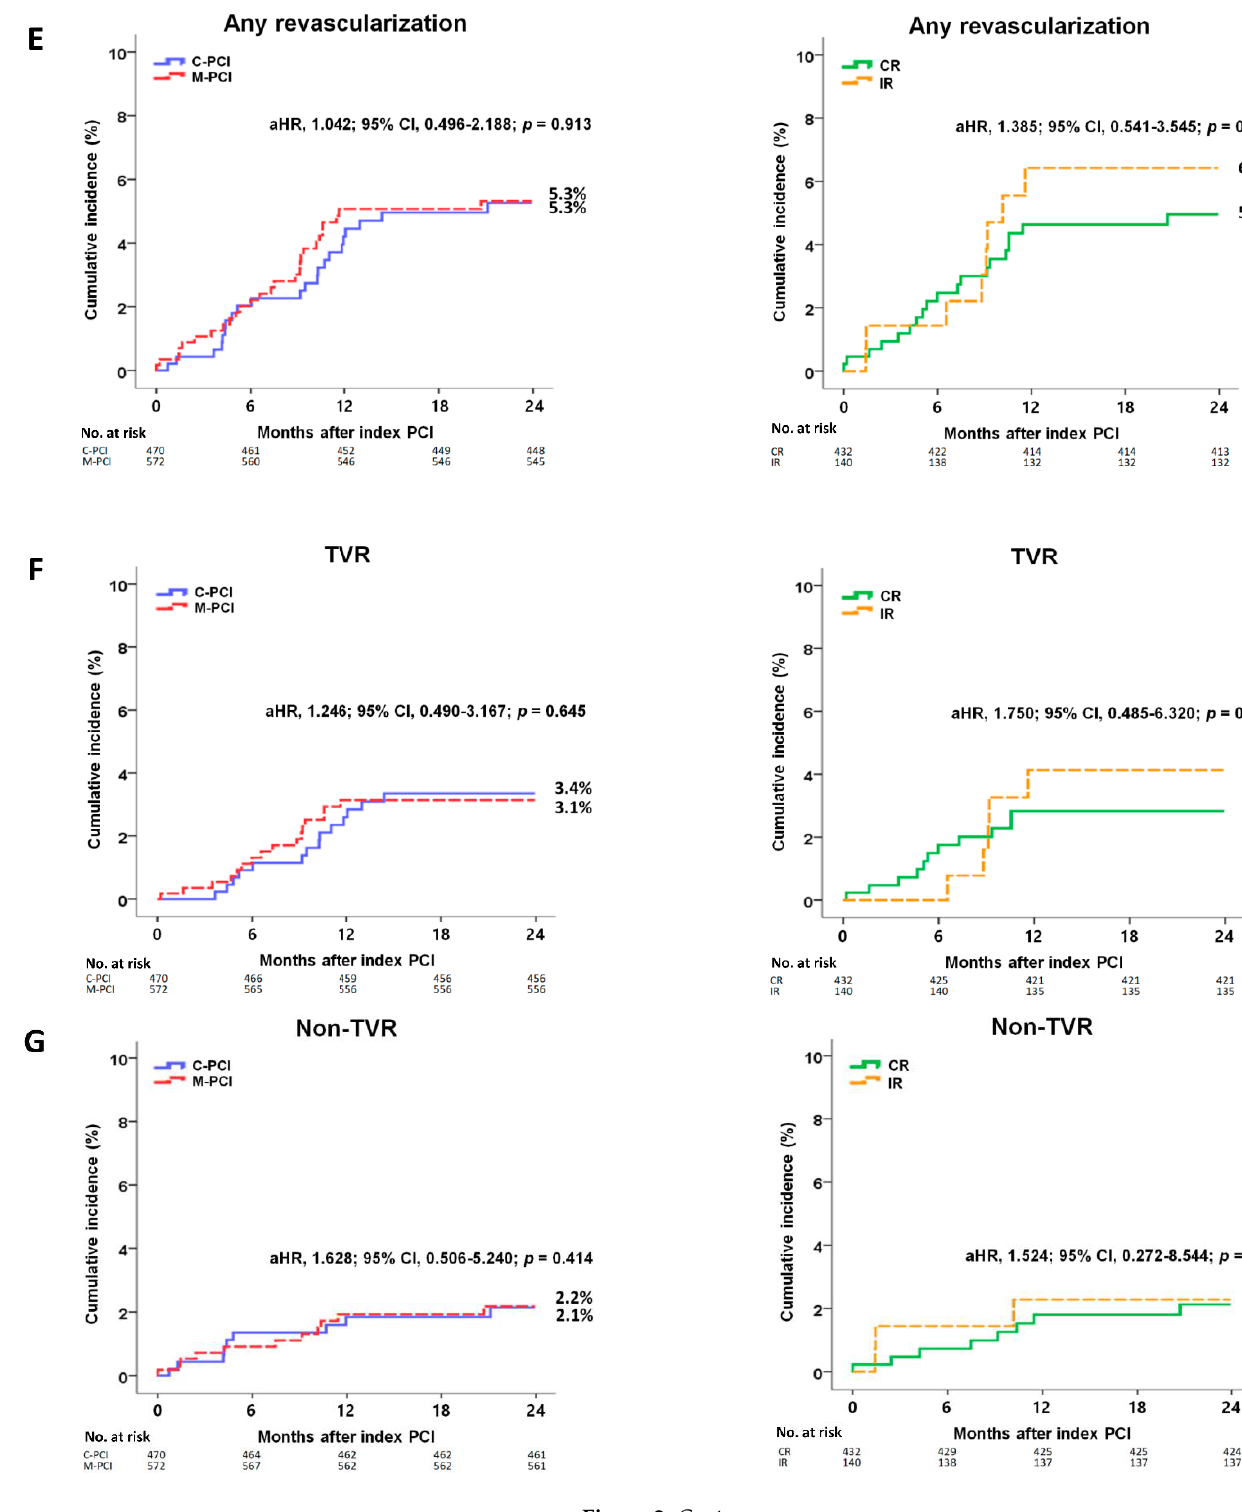
Figure 2. Kaplan-Meier analyses for the MACE ( A ), all-cause death ( B ), cardiac death ( C ), recurrent MI ( D ), any repeat revascularization ( E ), TVR ( F ), non-TVR ( G ) and ST ( H ) between the C-PCI group and the M-PCI group and the CR group and the IR group at 2 years. aHR, adjusted hazard ration; CI, confidence interval; MACE, major adverse cardiac events; MI, myocardial infarction; TVR, target vessel revascularization; C-PCI, culprit-only PCI; M-PCI, multivessel PCI; CR, com- plete revascularization; IR, incomplete revascularization. Table 3. Independent predictors for MACE. Unadjusted